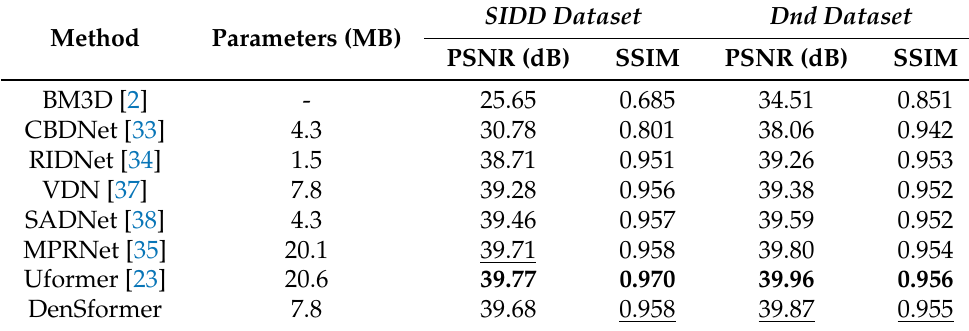
Table 3. Quantitative results about real blind image denoising.